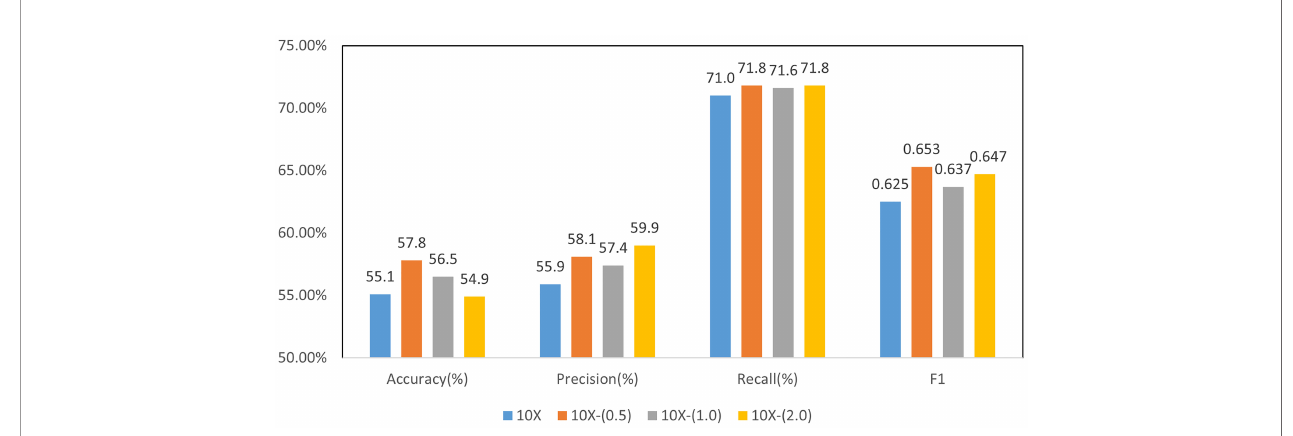
FIGURE 7 | Results of 4-class molecular subtype classi fi cation with MIL fi netuning at different